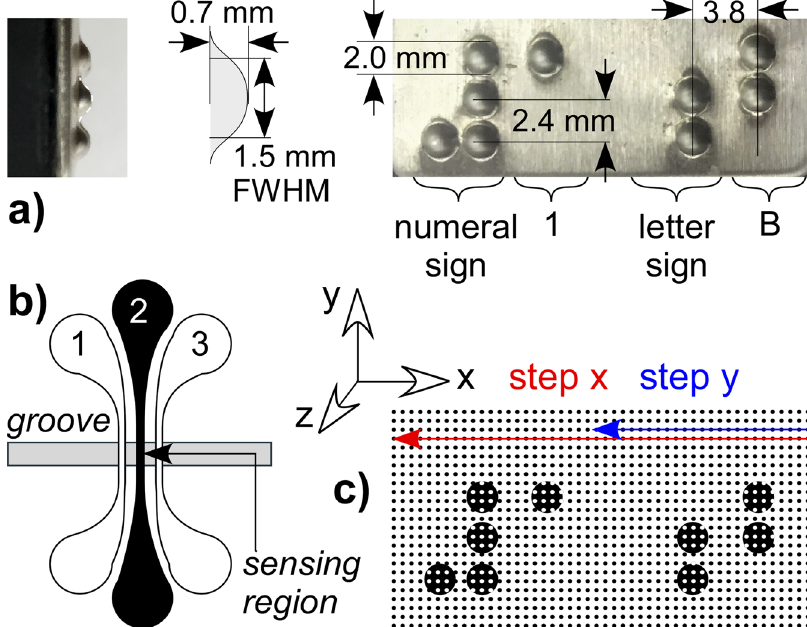
Figure 3. ( a ) Edge-on close-up of the stamped metal braille coupon, dimensions of the braille dots, and overhead close-up of the braille surface. ( b ) Schematic of the sensing strips over the groove; the latex membrane is not shown. Images were typically obtained using just one of the three sensors, labeled 1–3. ( c ) For the discrete scans, the sensor was stepped from right to left in the x -direction over the target by 0.5 mm increments, moved back to the right edge and up by 0.5 mm in the y -direction, and stepping in x begun again.